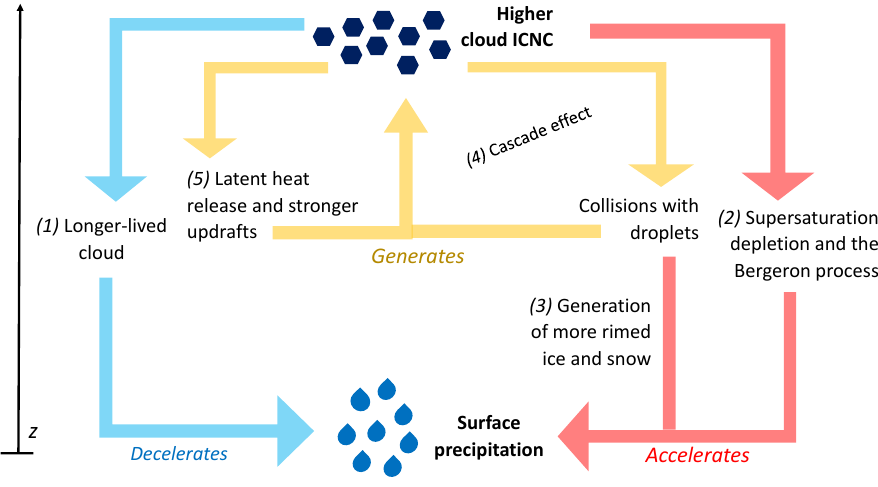
Figure 1. Within mixed-phase clouds, ice and its secondary production will impact surface precipitation in various ways. Precipitation rates could decelerate via a cloud lifetime effect (1), where small crystals stay aloft longer, or accelerate via supersaturation depletion (2), where larger crystals grow at the expense of liquid droplets via the Bergeron process. More frequent riming may simply generate more large and dense hydrometeors that can fall out and melt to generate more surface precipitation (3). Additional crystals due to droplet freezing could also generate a cascade effect (4) whereby the generation of more ice leads to more collisions with droplets that leads to generation of more ice. The latent heat release upon droplet freezing can also invigorate updrafts